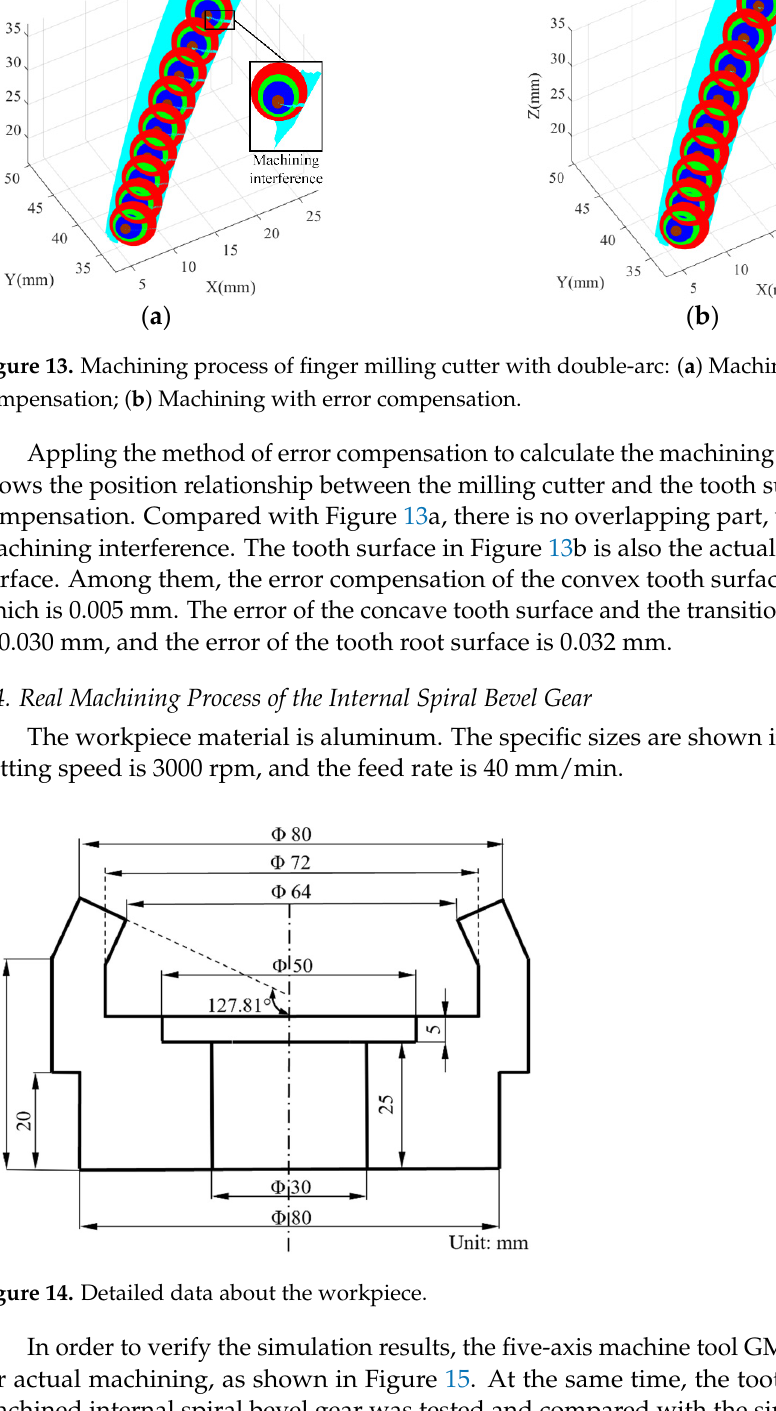
( d ) Figure 12. Machining simulation: ( a ) Machining the convex tooth surface; ( b ) Machining the transi- tion tooth surface; ( c ) Machining the concave tooth surface; ( d ) Machining the root tooth surface.